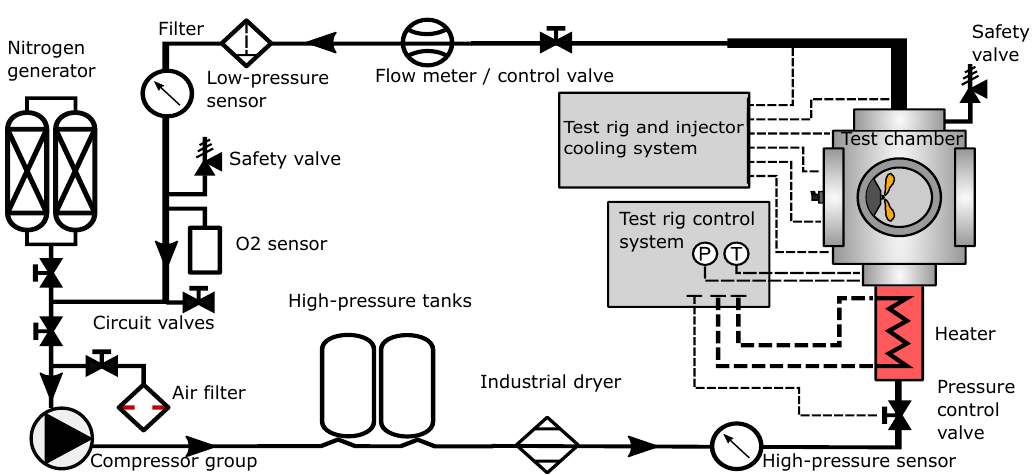
Figure 1. Schematic diagram of the high-temperature and high-pressure facility.